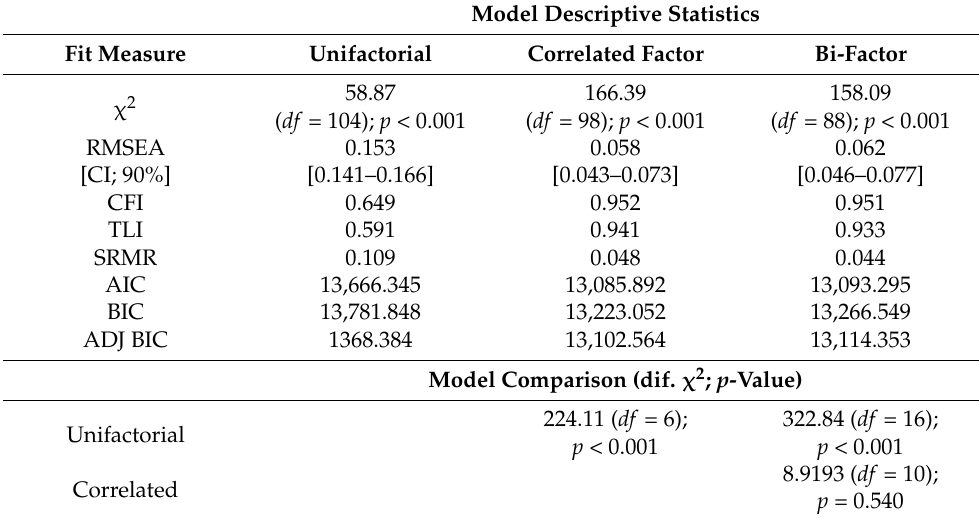
Table 3. Fit index values for WEIP-S models.